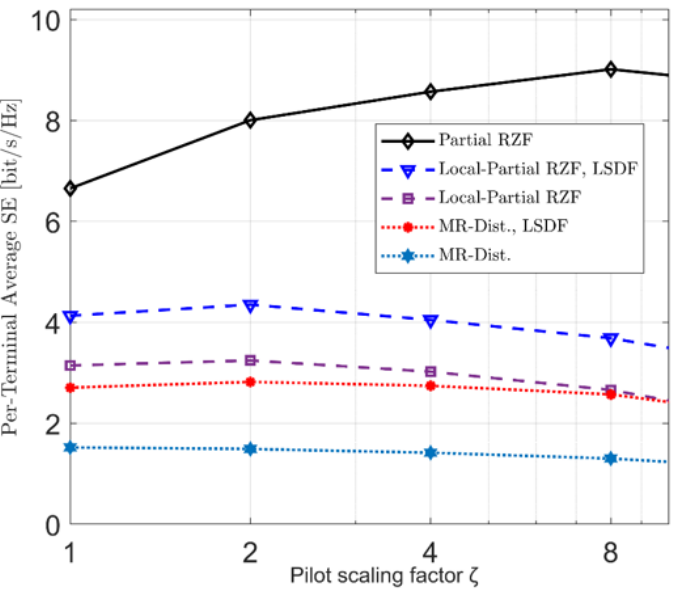
Figure 5. Average achieved SE as a function of pilot scaling factor, with K = 128, L = 1024, and τ 0 = 8.